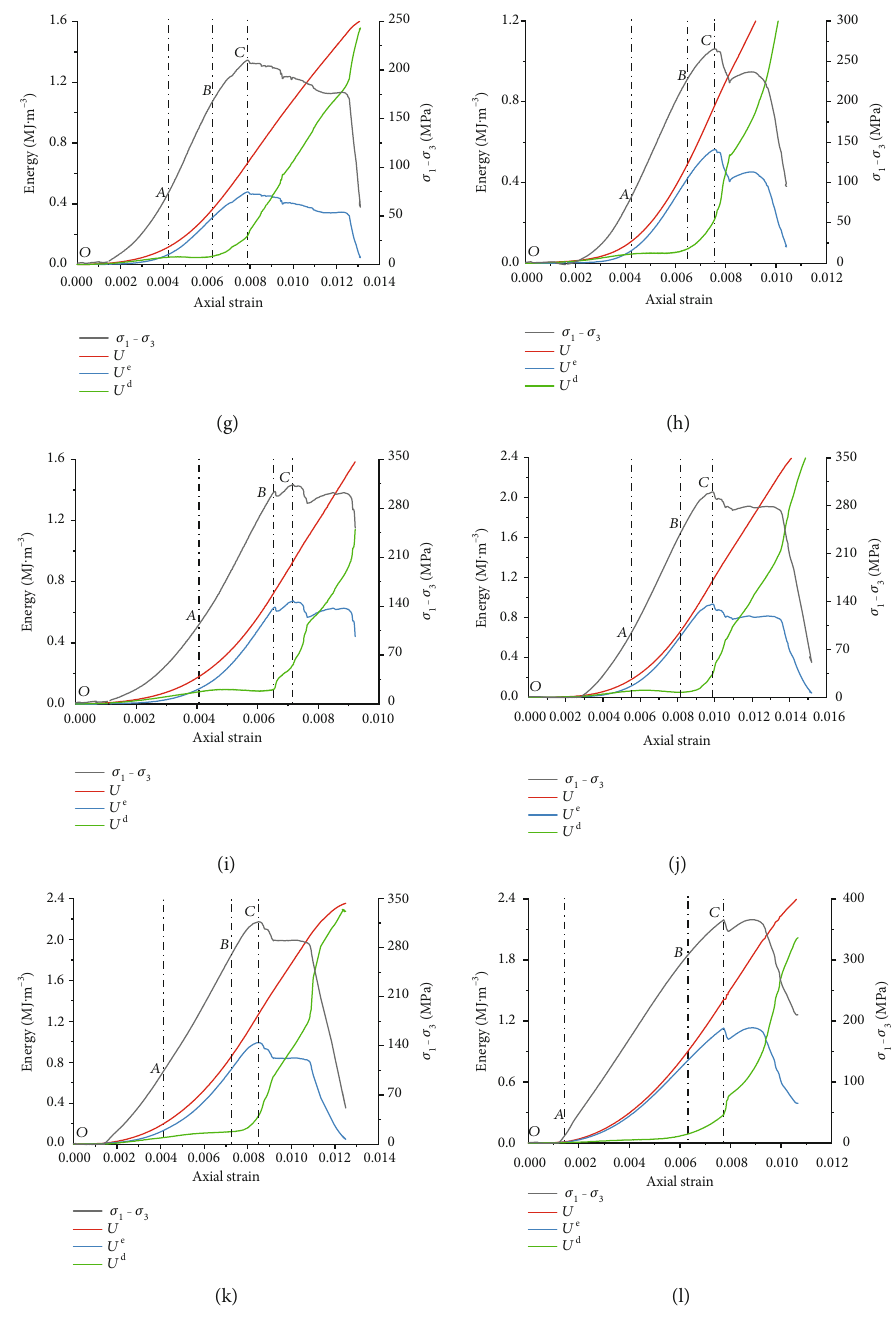
= 0 MPa; (b) natural state, 3 = 5 MPa; (f) dry state, σ = 5 MPa; (g) saturated 3 3